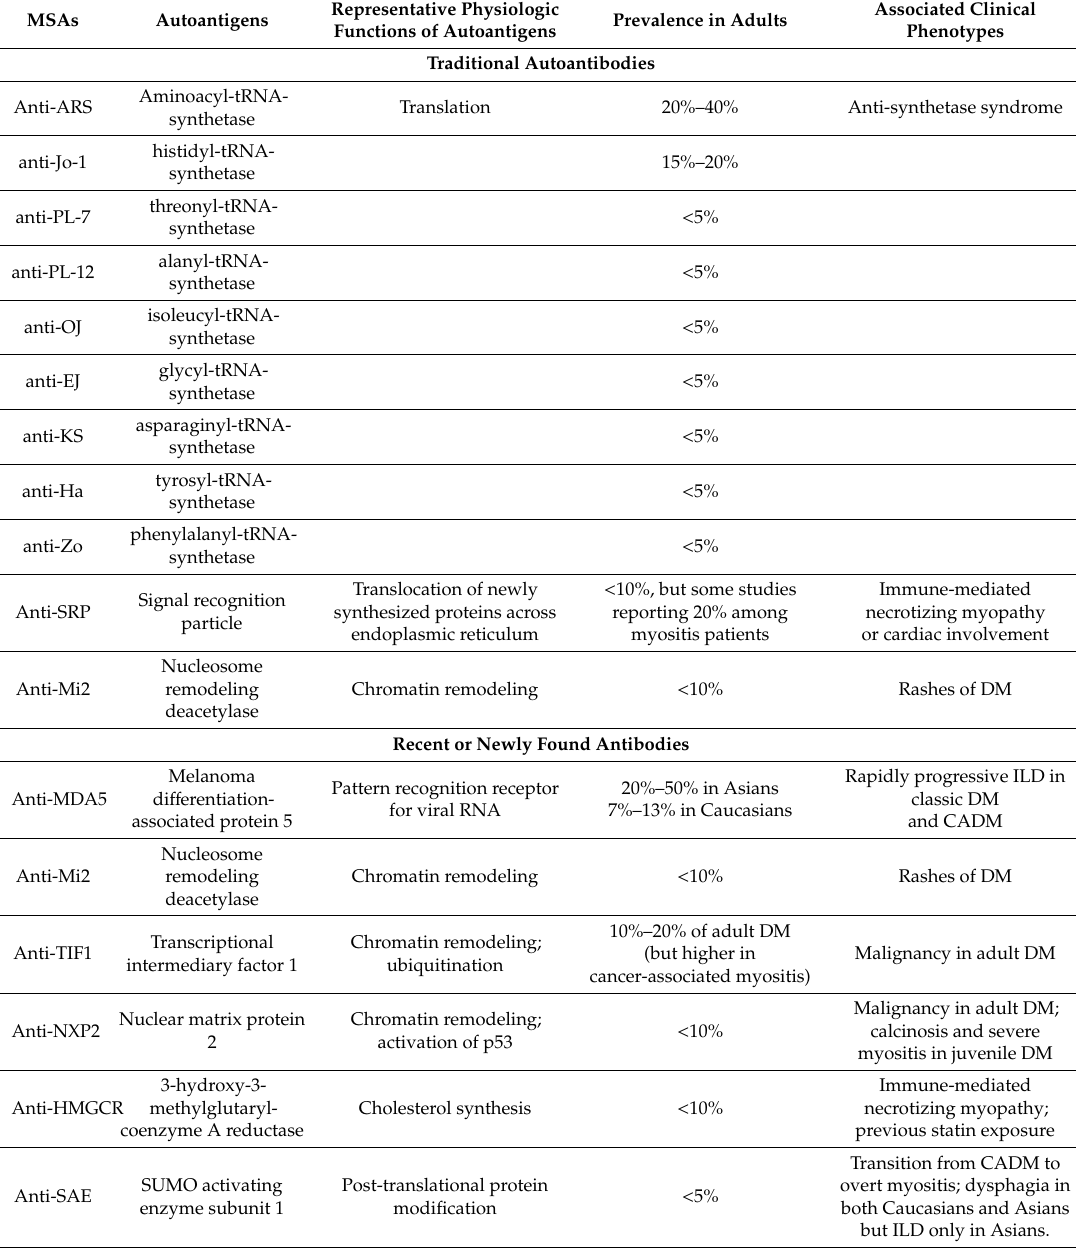
Table 1. Summary of myositis-specific